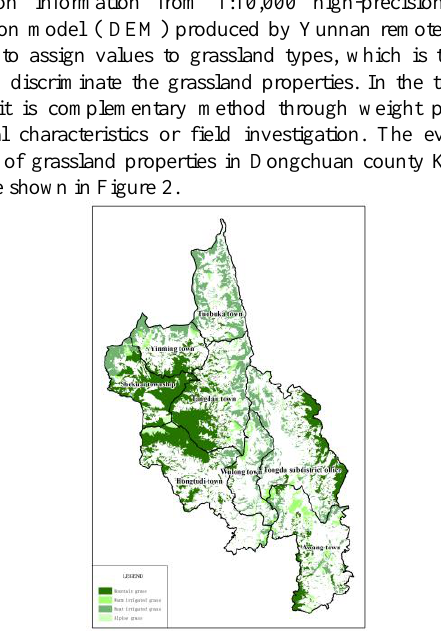
Figure 2. Grassland type map of Dongchuan